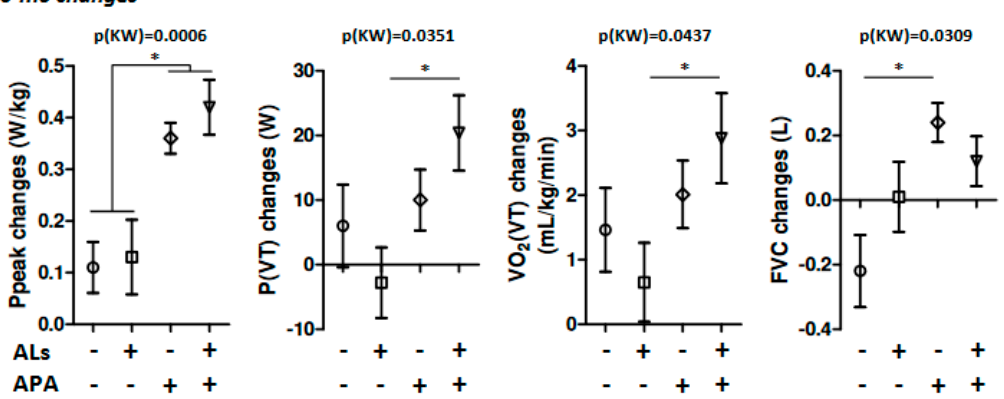
Figure 2. Changes after 6 months of treatment. Changes in the maximal power (Ppeak), power at ventilator threshold (P(VT)), O2 consumption at VT, and forced ventilator capacity (FVC) observed after 6 months of treatment in the 4 groups of patients receiving (or not) arginine and leucine supplementation (ALs) and following (or not) the adapted physical activity program (APA). Data were compared by the Kruskal–Wallis test (KW) followed by Dunn post tests. * p < 0.05.